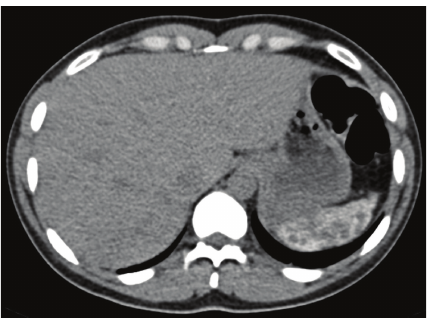
Figure 1: Computed tomography scan section, depicting diffuse calcifications of the